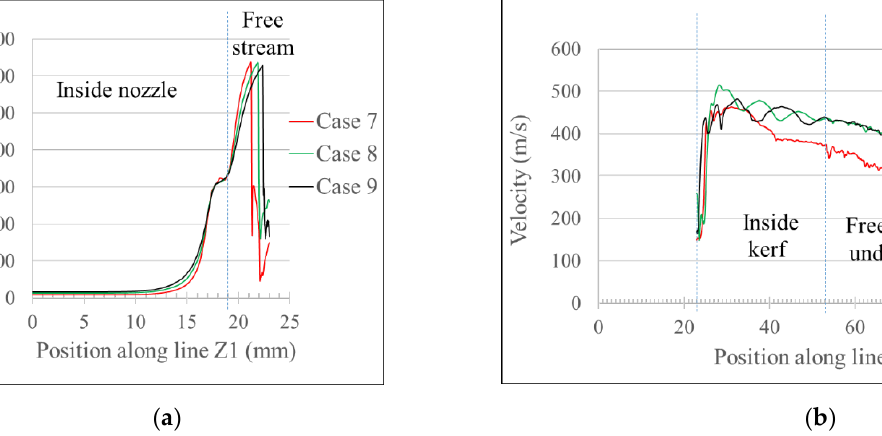
Figure 17. Velocity distribution curve for various nozzle configurations in kerf slot (l offset = 9 mm): ( a ) along line Z1 and ( b ) along line Z2.